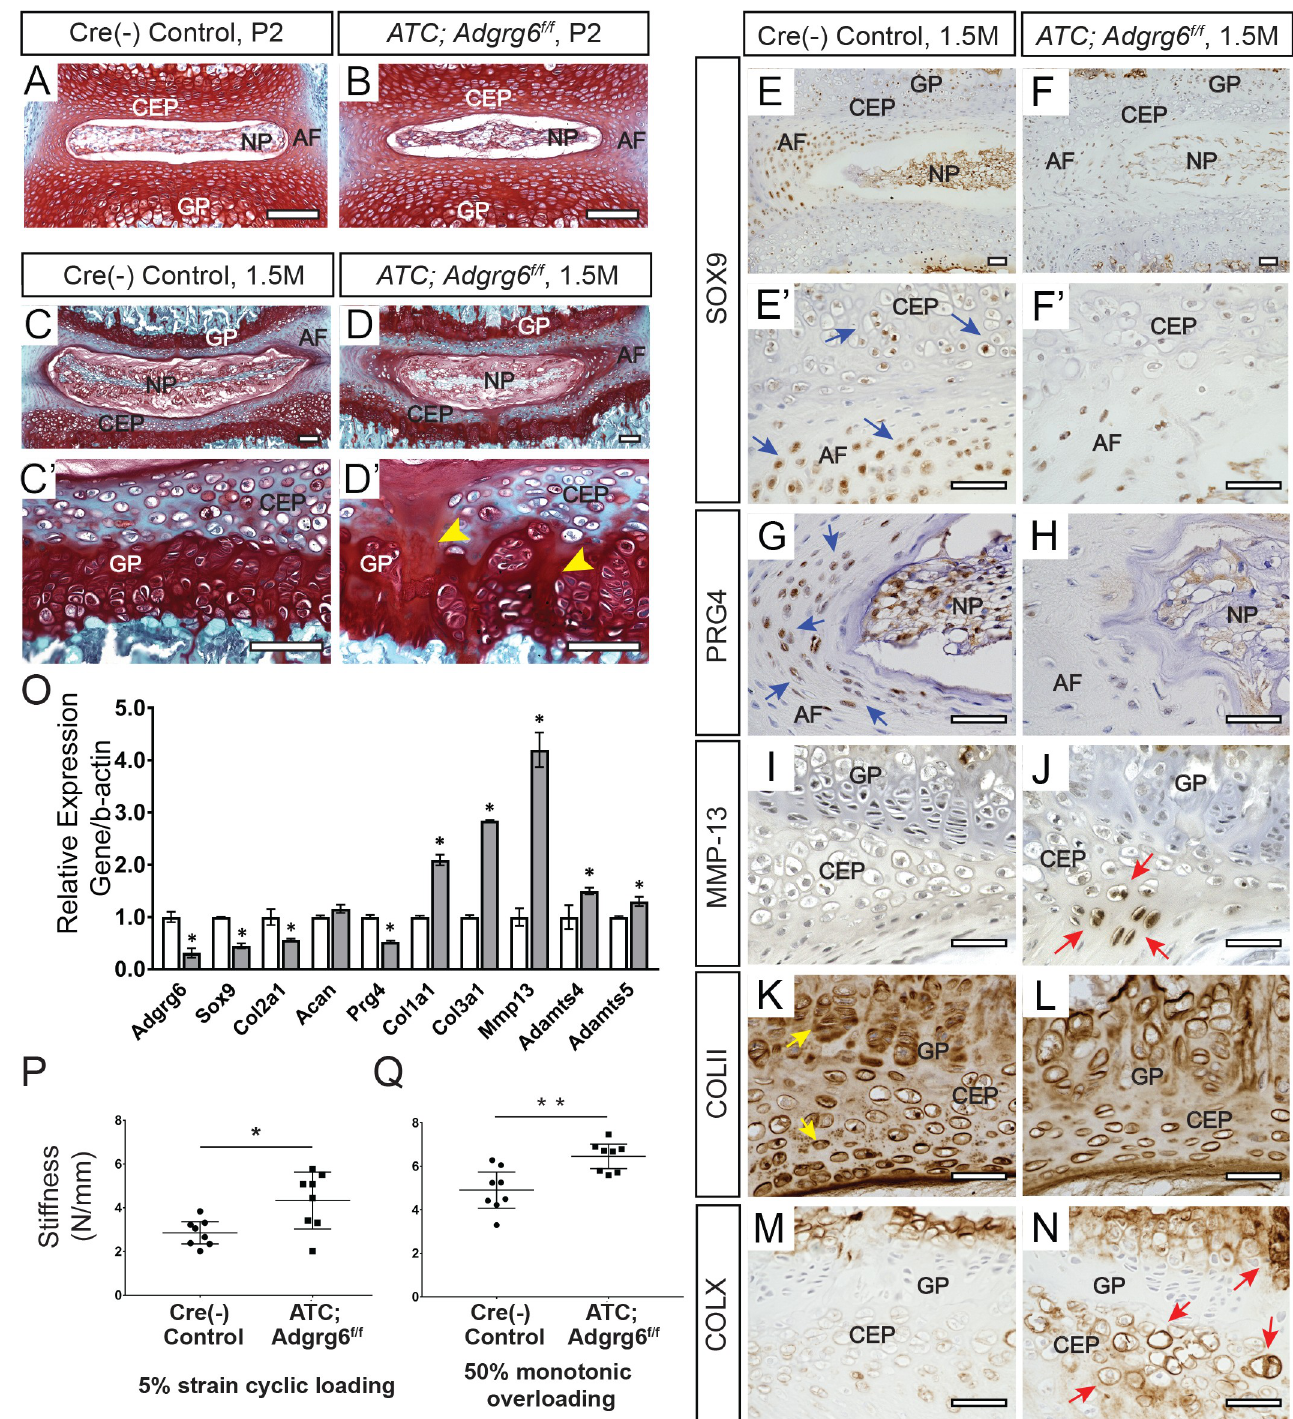
Fig 2. Young ATC;Adgrg6 f/f mutant mice display alterations in IVDs consistent with disc degeneration pathology. (A-D’) Representative IVD tissues stained Safranin-O/Fast green (SO/FG) (Induced from E0.5-P20, n = 3 for each group.) No overt structural defects were observed in ATC;Adgrg6 f/f mutant IVDs compared with controls at P2 at midline (A, B) or at 1.5 months of age (C-D’), except for the mild increase of acellular clefts in the CEP and GP at 1.5 months (yellow arrowheads, D’). Section in panel D is a little bit pass midline to show the obvious acellular clefts in CEP and GP. (E-O) IHC (E-N) and qPCR (O) analyses of common markers of degenerative disc in mice at 1.5 months (induced from E0.5-P20). ATC;Adgrg6 f/f mutant IVDs display reduced expression of markers of healthy disc: SOX9/ Sox9 (blue arrows, E’) and PRG4/ Prg4 (blue arrows, G), and mildly reduced COLII/ Col2a1 (yellow arrows, K). They also display